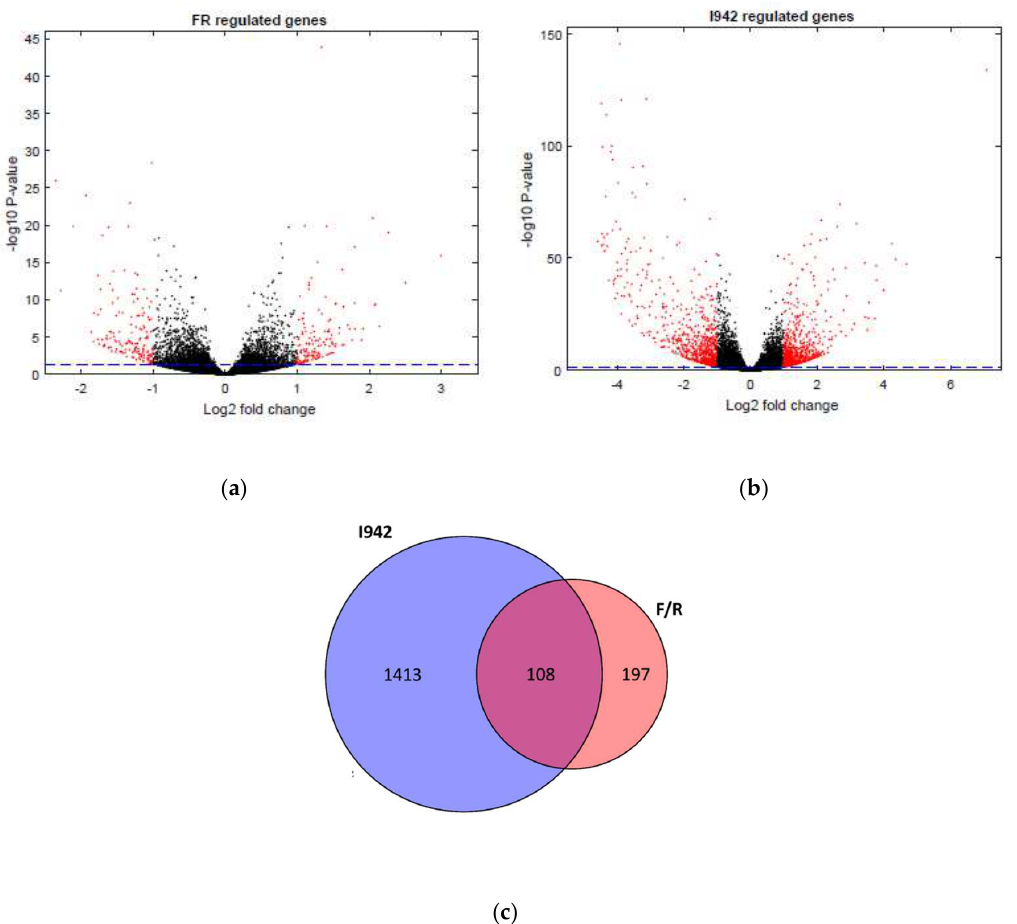
Figure 1. In order to identify genes regulated by I942, confluent human umbilical vein endothelial cells HUVECs were stimulated for 48 h with ( a ) 10 µ M forskolin plus 10 µ M rolipram (F / R) or ( b ) 100 µ M I942. Total RNA was then extracted from cells and processed for RNA-SEQ and plotted as volcano plots as described in Materials and Methods, with gene expression changes greater than 2-fold being indicated in red. Genes that were significantly ( p < 0.05, dotted blue line) regulated individually or by both treatments (see Supplementary Materials) are expressed as a Venn diagram in ( c ).